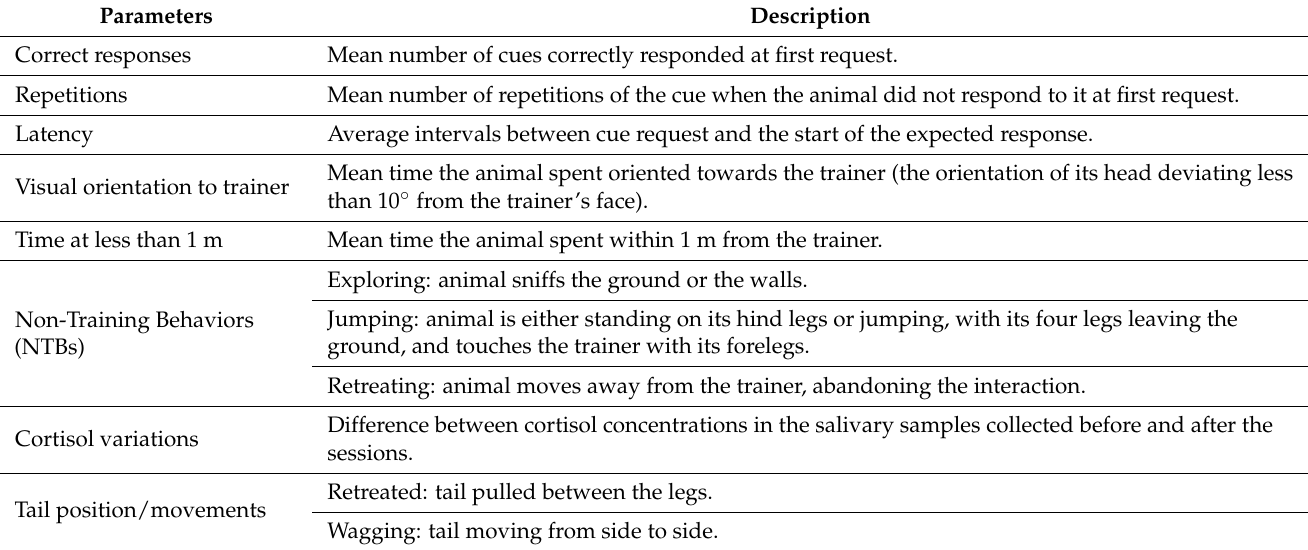
Table 3. Description of the behaviors of socialized dogs ( Canis familiaris ) and wolves ( Canis lupus ), obtained for each training session.